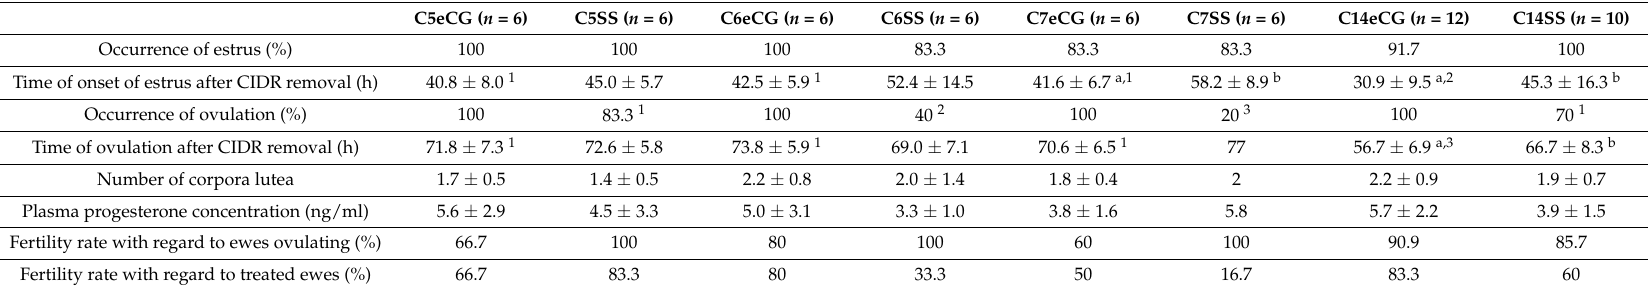
Table 1. Percentage and timing of the occurrence of estrus and ovulation, number of corpora lutea, progesterone secretion, and fertility in ewes treated with Controlled Internal Drug Release (CIDR) for five, six, seven, and fourteen days (groups C5, C6, C7, and C14, respectively), with equine chorionic gonadotrophin or physiological saline solution (groups eCG and SS,